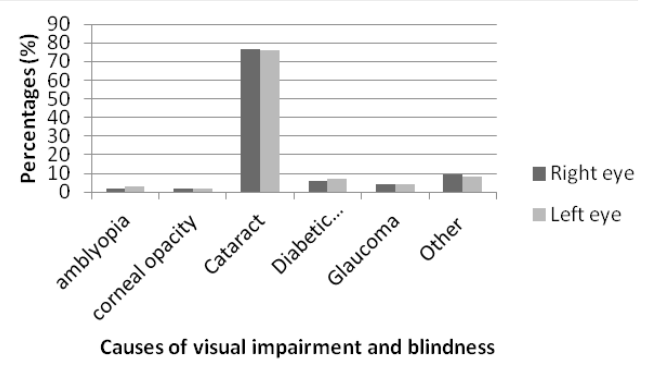
Figure 3: The causes of visual impairment and blindness in the right and left eyes of the